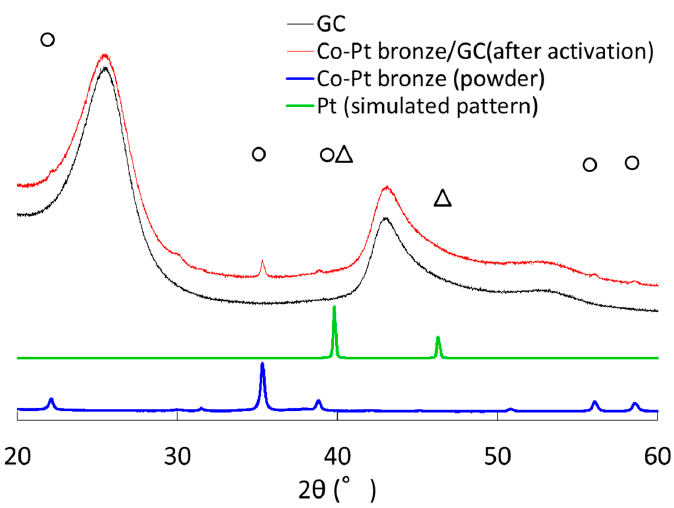
Figure 9. XRD pattern of Co-Pt bronze on glassy carbon after the activation treatment compared with those of Co-Pt bronze powder, glassy carbon and Pt metal.